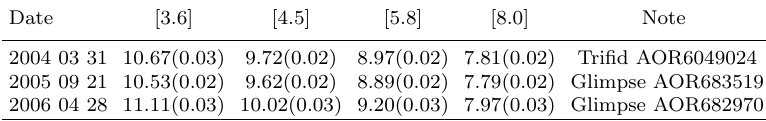
Fig. 5. The position of V2282 Sgr in the J – H vs. H – K plot at three epochs from the literature data: the main sequence locus and the reddening line are shown. It is evident that the source was redder when it was fainter, as expected in case of matter ejection. Table 3. Spitzer -IRAC photometry of V2282 Sgr.